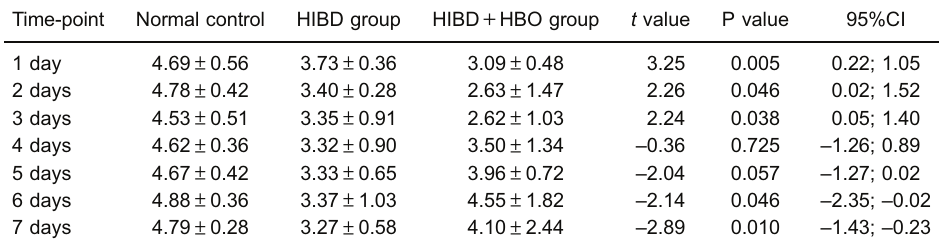
Table 2. Mitochondrial membrane potential (in mean fl uorescence level, MFL) in ipsilateral cortex after a single dose of hyperbaric oxygenation (HBO) in 7-day interval after hypoxic-ischemic brain damage (HIBD).